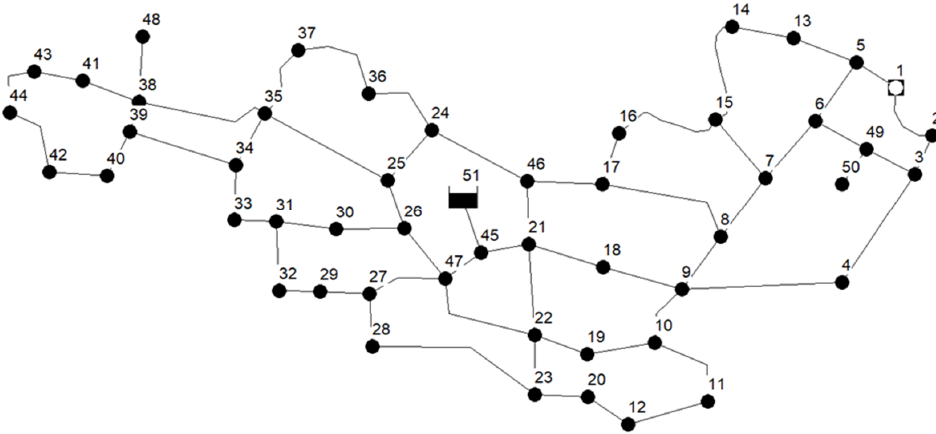
Table 4. Diameter options and associated unit costs for large network.